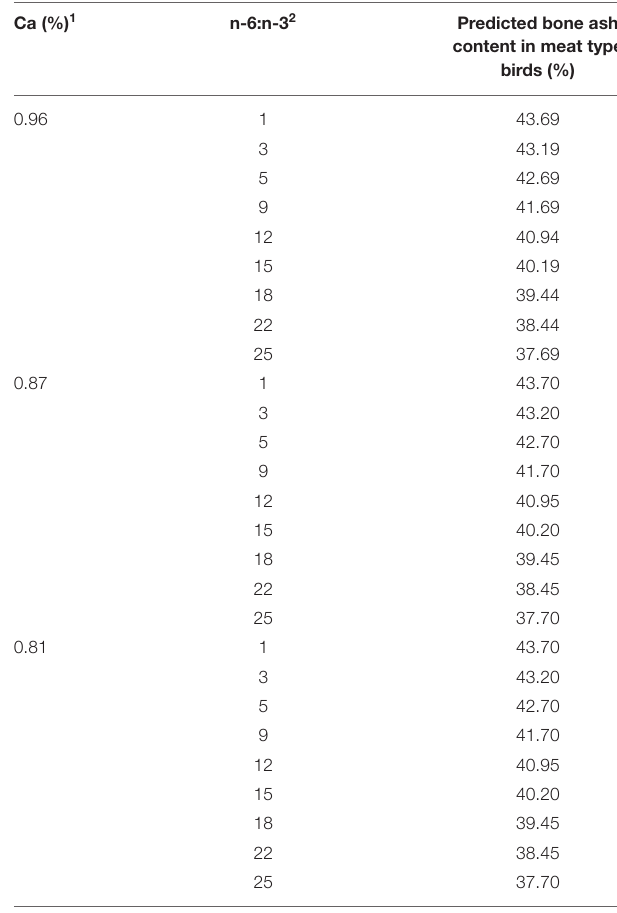
TABLE 5 | Predicted BAC (%) for meat birds using the developed model, where BAC (%) = 44.01 – 0.25 (dietary n-6:n-3) – 0.07 (Ca concentration diet, %). Ca (%)